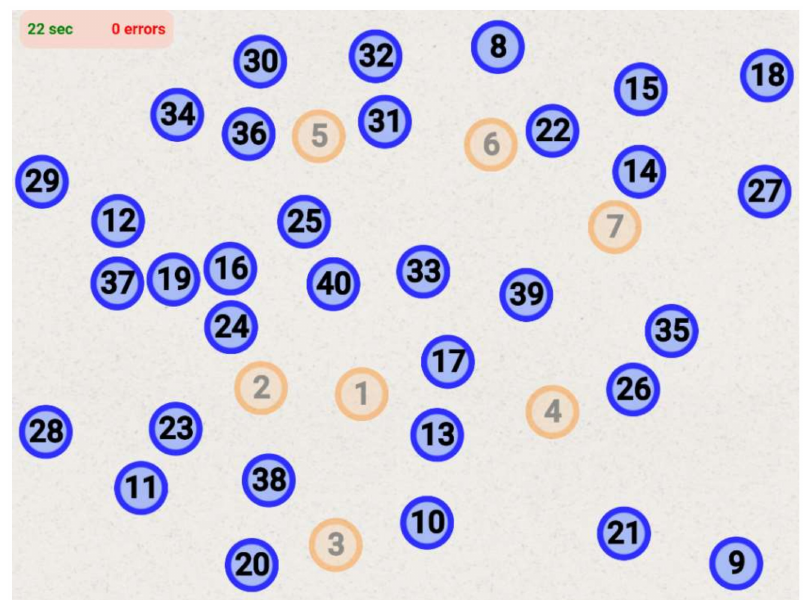
Figure 2. A modified electronic version of the Trail Making Test (TMT): The player taps the circles in ascending order as quickly as